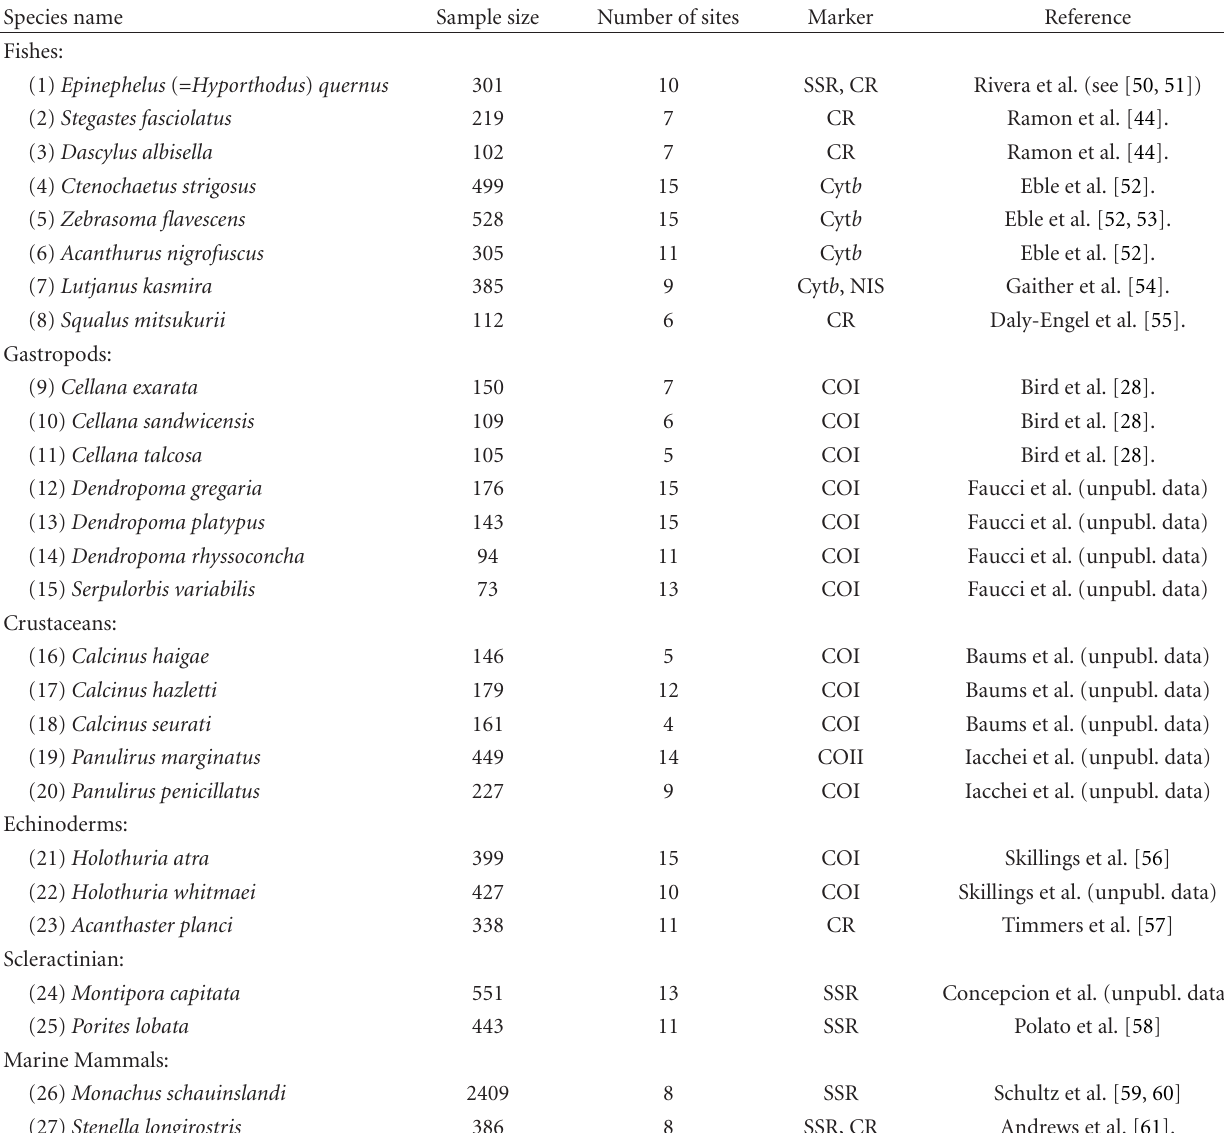
Table 1: Species of marine organisms, total sample size, total number of sites, genetic marker(s) used, and study citation for each of the organisms surveyed for population genetic structure across the Hawaiian Archipelago to date. Not all samples were included in subsequent analysis, therefore, the actual sample sizes by site for each species in this analysis are provided in Table 2. Abbreviations for genetic markers used are: SSR = microsatellites; NIS = nuclear intron sequence data; Cytb = cytochrome b ; COI = cytochrome oxidase subunit I; COII = cytochrome oxidase subunit II; CR = control